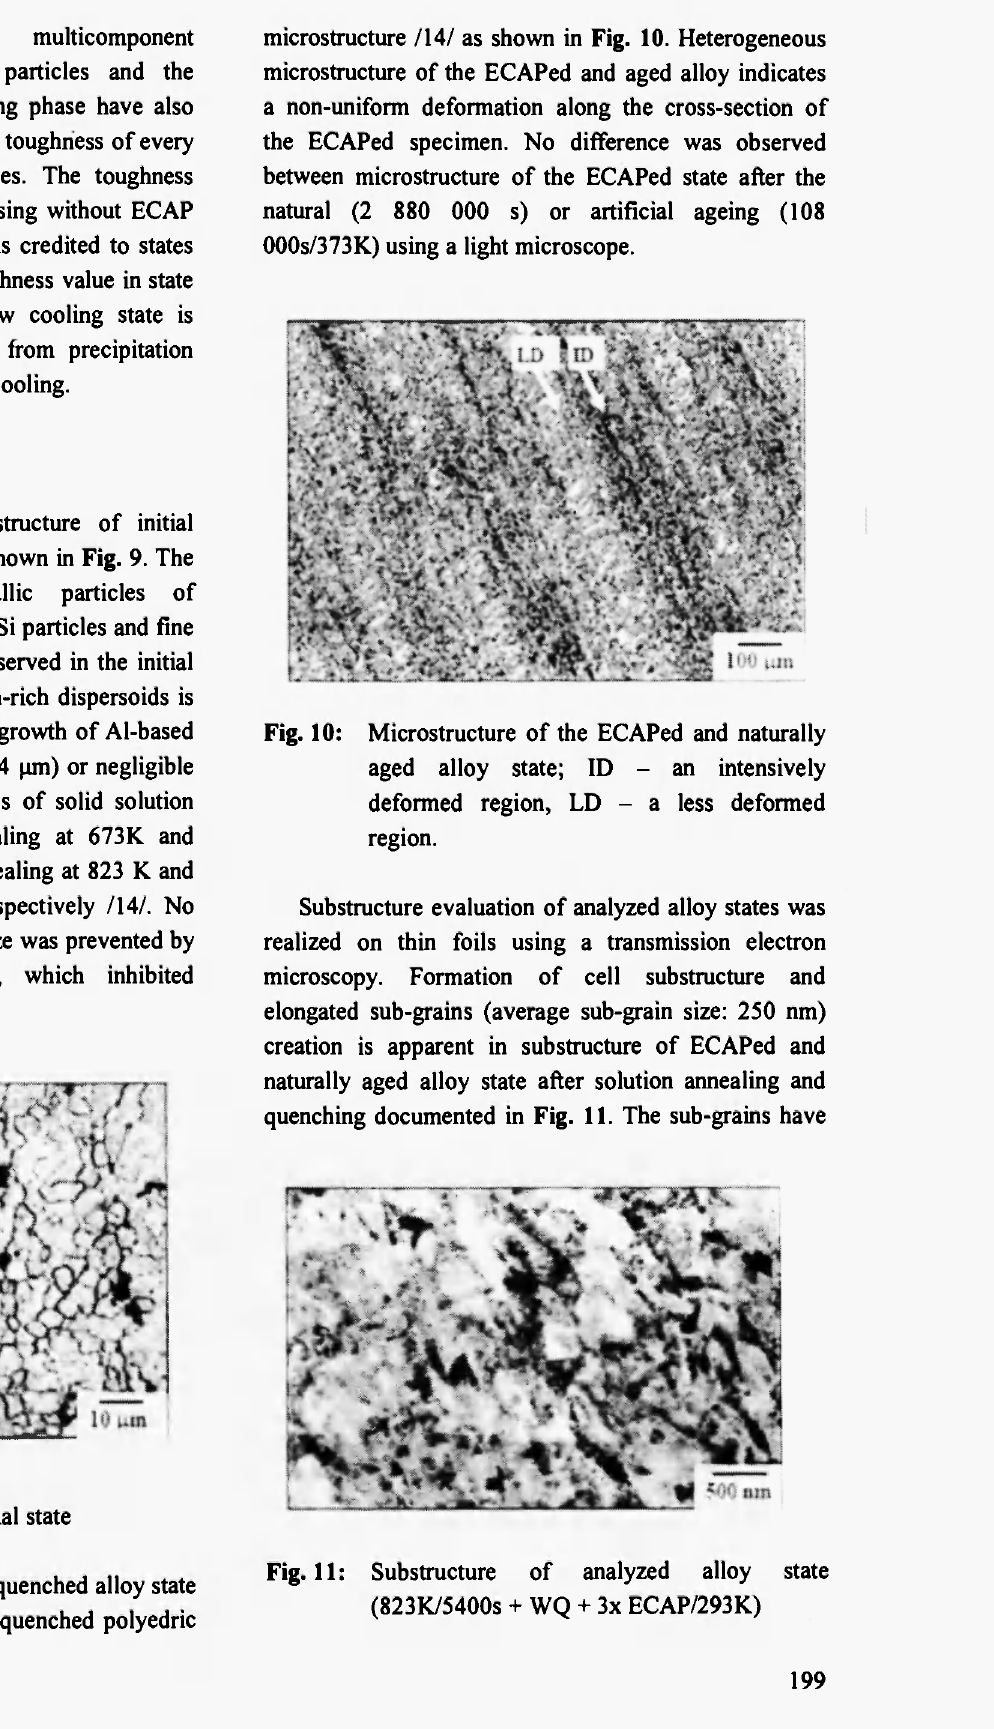
Fig. 9: Microstructure of alloy - initial state The repetitive ECAP process of quenched alloy state induced a significant change of the quenched polyedric